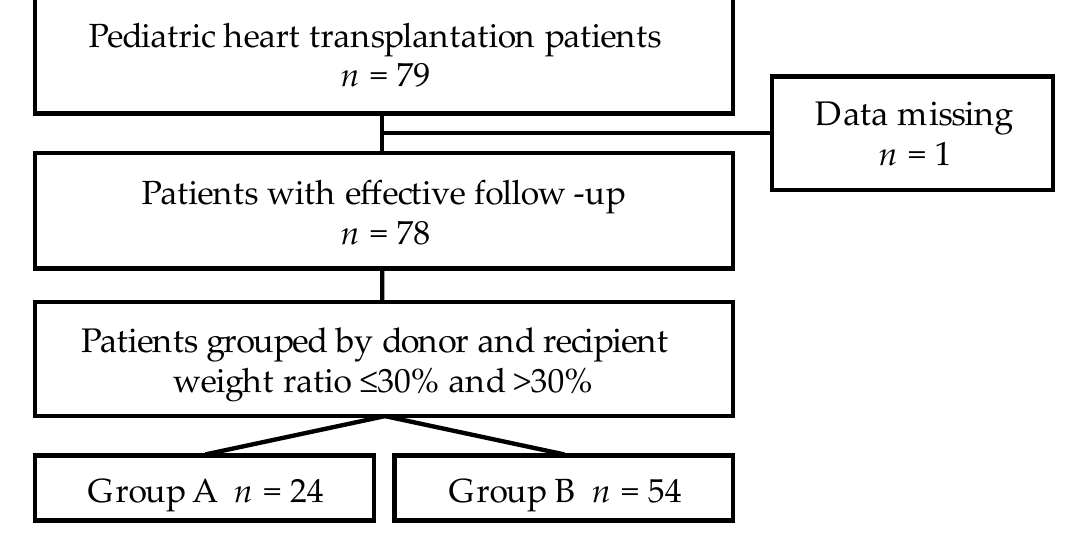
Figure 1. Study cohort design flow chart. All 79 pediatric cardiac transplant patients at Wuhan Union Hospital from January 2015 until December 2020 were recruited. One patient was lost to the follow-up period. A total of 78 recipients were finally enrolled in the study cohort according to the inclusion criteria.